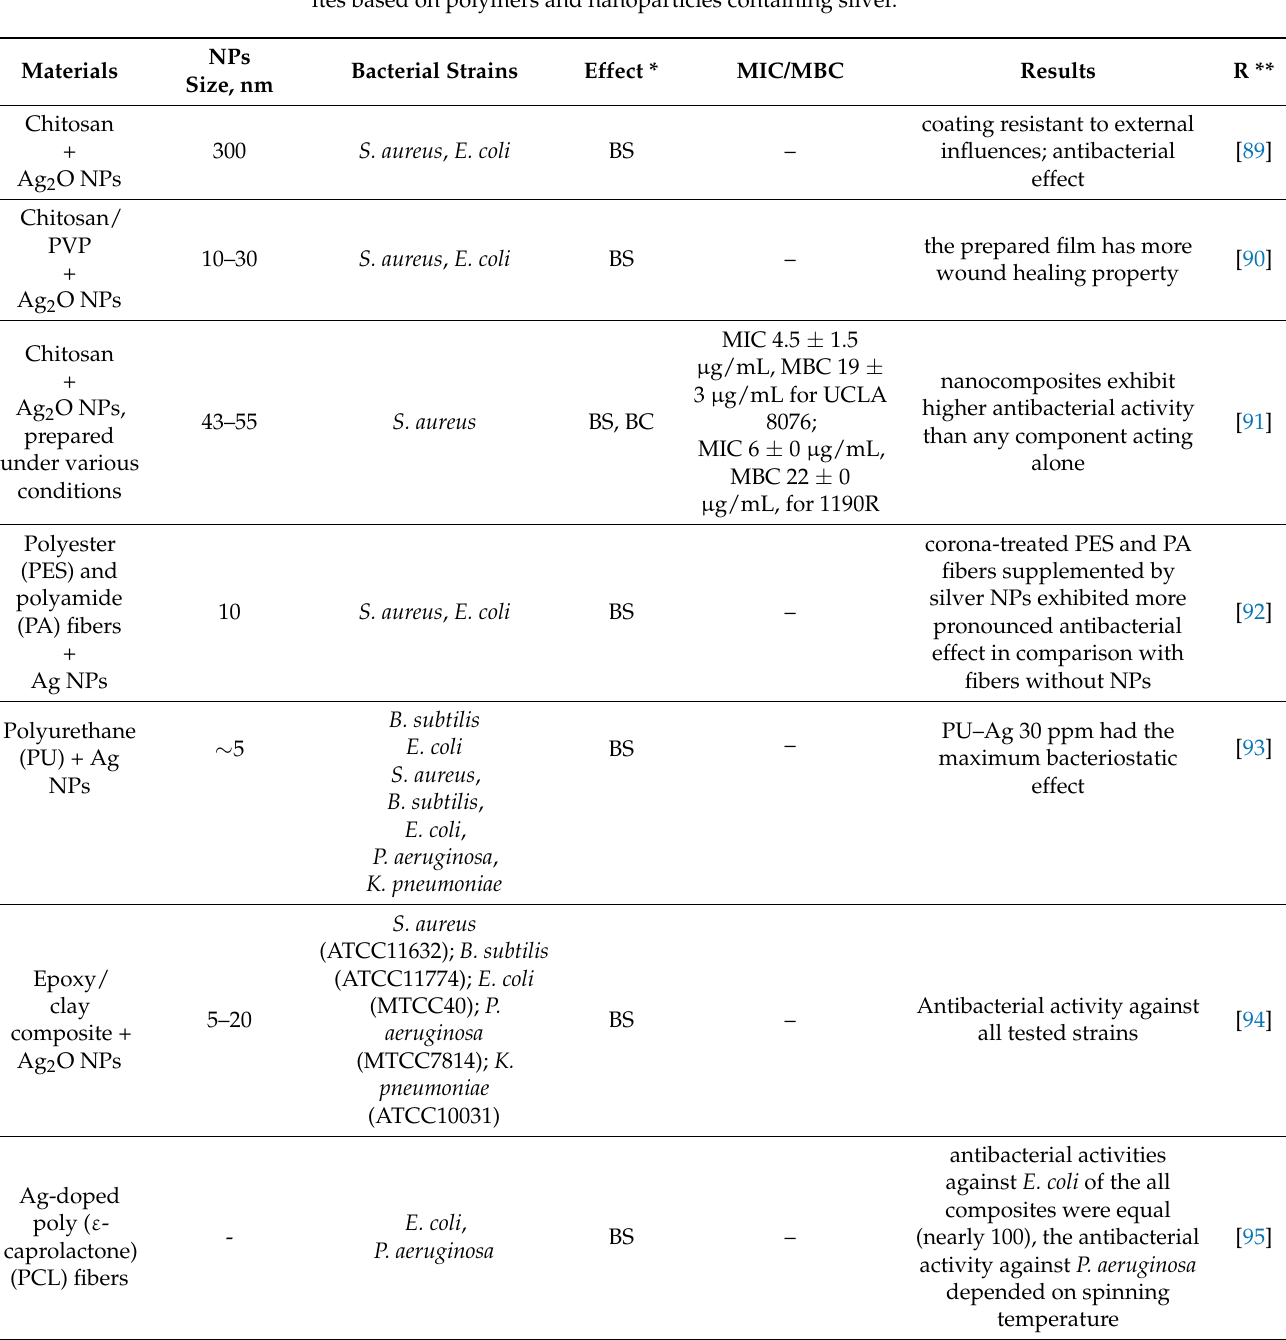
Table 1. Comparison of physical and biological properties of previously manufactured nanocompos- ites based on polymers and nanoparticles containing